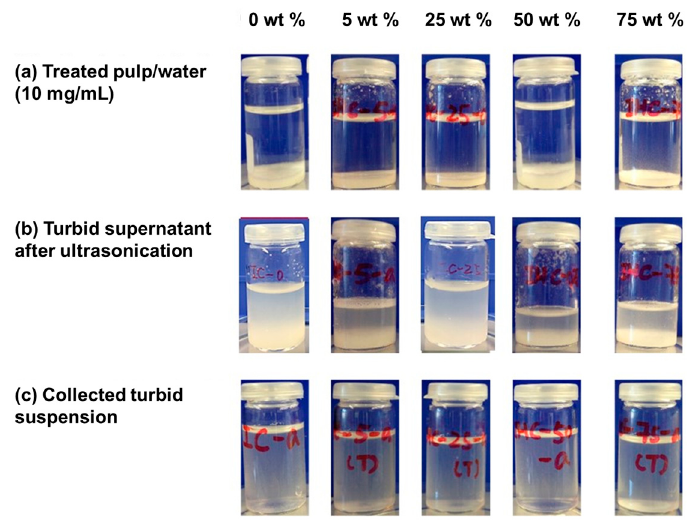
Figure 2. Dispersions of the treated pulps (imi-HWP) 0, 5, 25, 50 and 75 wt % represent the water contents of the used imidazole/water systems) ( a ); dispersions after sonication at a power level of 60% for 1 min ( b ); and the dilute turbid suspensions (SUP) (0.1 wt %) after standing for one week ( c ).